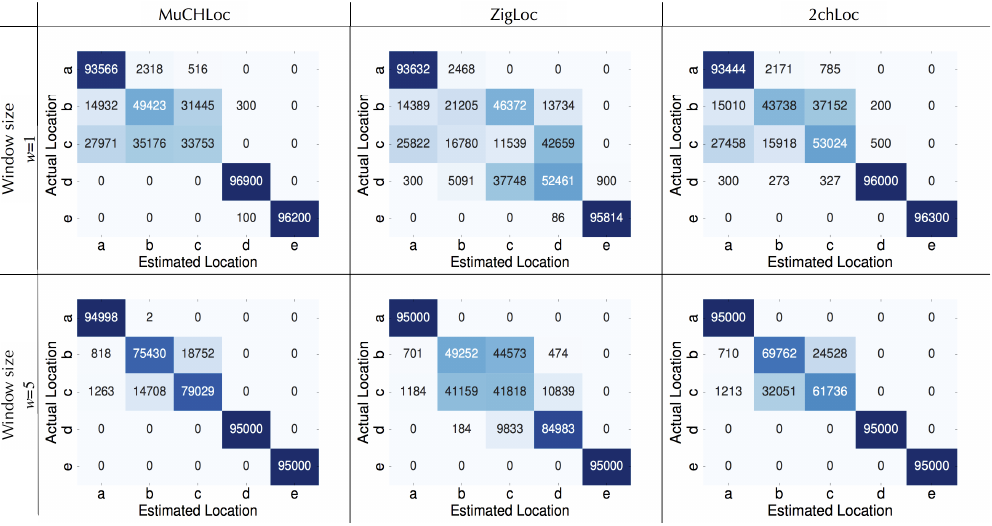
Figure 10. Confusion matrices of the results of location estimation (window size w = 1,5). Each cell represents the number of